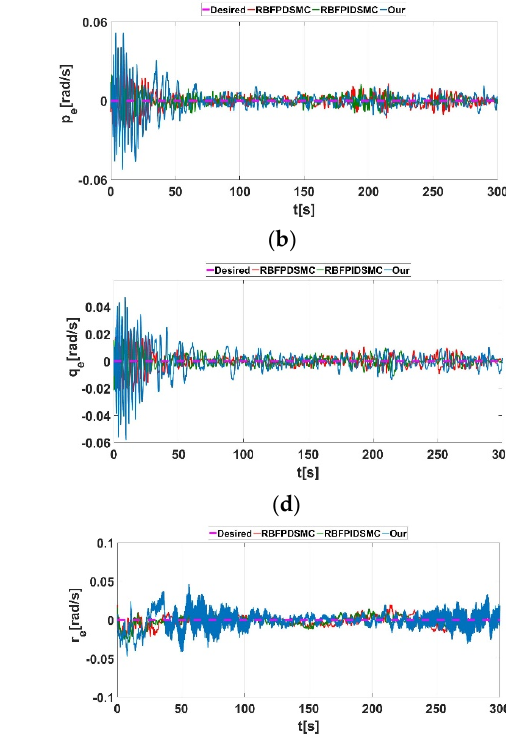
Figure 7. AUV position − tracking errors. ( a ) 𝑥 𝑒 ; ( b ) 𝜑 Figure 8 shows the speed-tracking errors of six degrees of freedom: 𝑢 𝑒 , 𝑣 𝑒 , 𝑤 𝑒 , 𝑝 , and 𝑟 𝑞 𝑒 . We analyzed the velocity tracking error and found that (1) The velocity track- 𝑒 ing errors of the three methods could converge to a certain range of bounded regions.